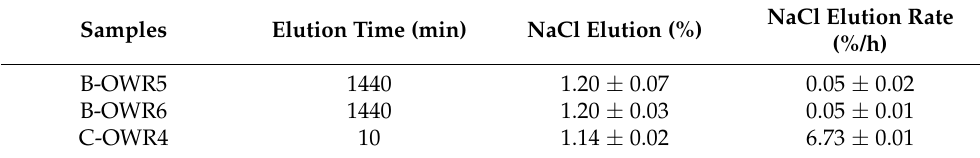
Table 3. Comparison of the optimum conditions between the batch and continuous systems.